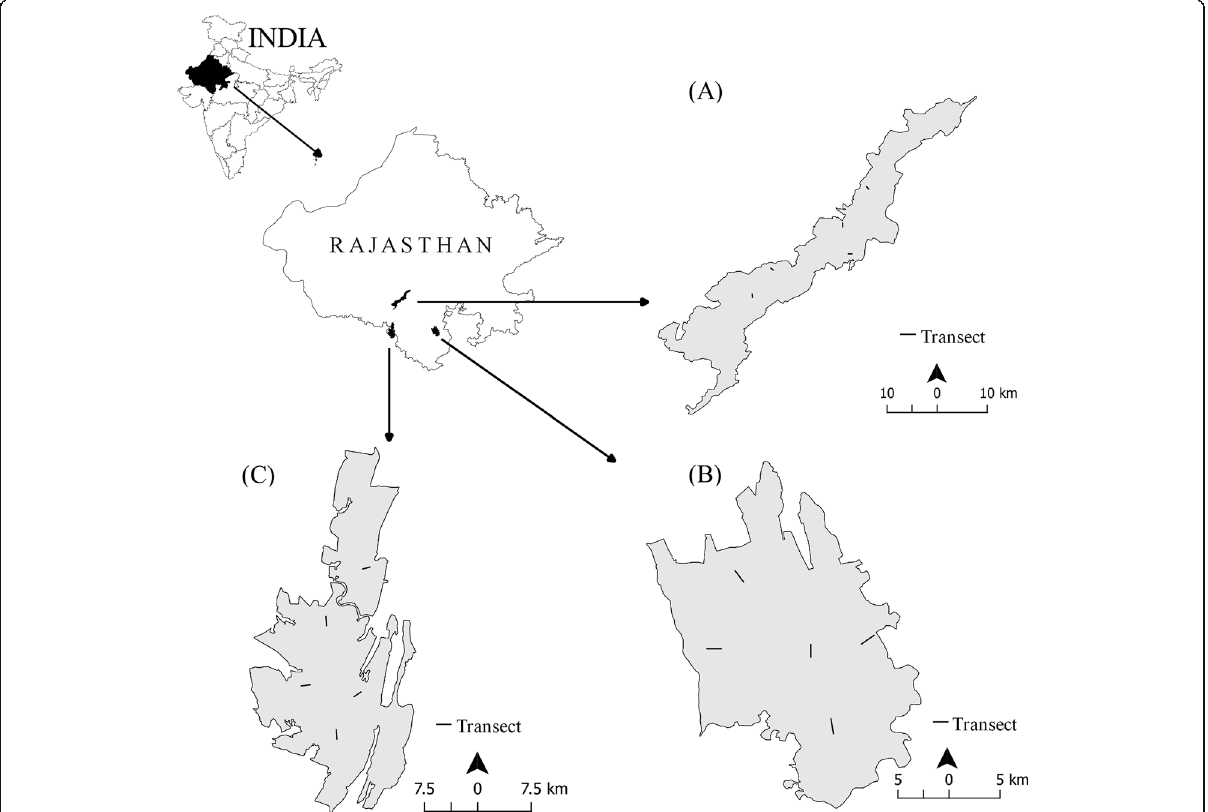
Fig. 1 Location of the study area, i.e., Kumbhalgarh Wildlife Sanctuary ( a ), Sitamata Wildlife Sanctuary ( b ), and Phulwari-ki-nal Wildlife Sanctuary ( c ) in southern Rajasthan,